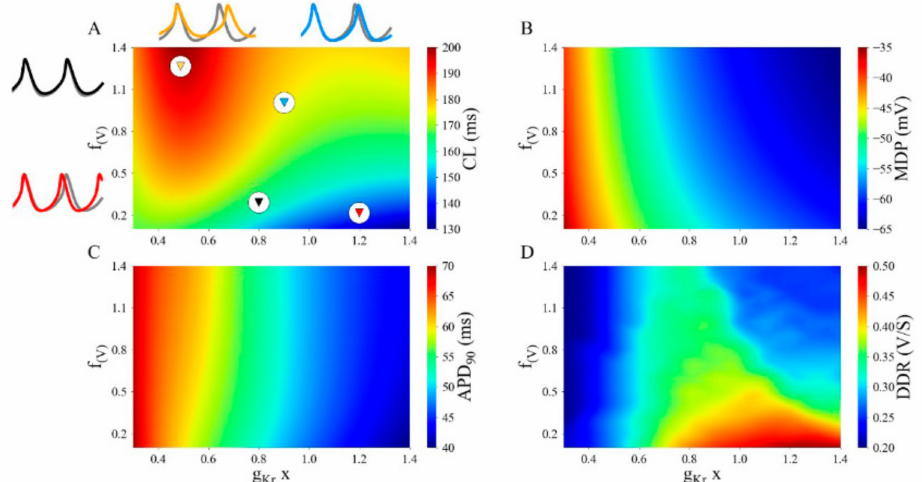
Figure 7. Effects of systematic changes in the maximal conductance for I Kr on SAN electrophysiologi- cal parameters. The heat maps in each panel of this Figure depict changes in the parameter named at the right, in response to incremental changes in g Kr in the range 0.3 to 1.4; made in conjunction with changes in the ratio, (f (v) ), that sets the relative sizes of the slow and fast components of I Kr activation and deactivation. The parameter g Kr was changed from 30% to 140% of its control or baseline values; and f (v) was set to fixed values in the range 0.1 to 1.4. Thus, simulated results were based on relatively small to relatively large ratios of the slow vs. the fast component of I Kr . Panel ( A ) denotes changes in cycle length, CL; Panel ( B ) shows alterations in maximum diastolic potential, MDP; Panel ( C ) illustrates changes in APD 90 ; Panel ( D ) shows changes in DDR, the slope of the diastolic